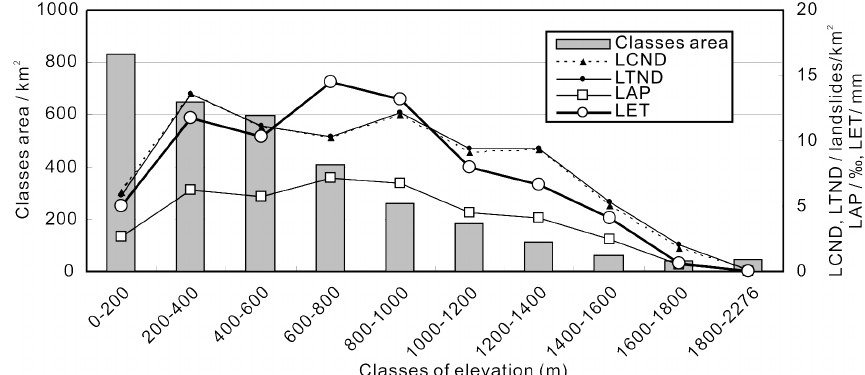
Figure 17. Relationship of co-seismic landslide abundances with